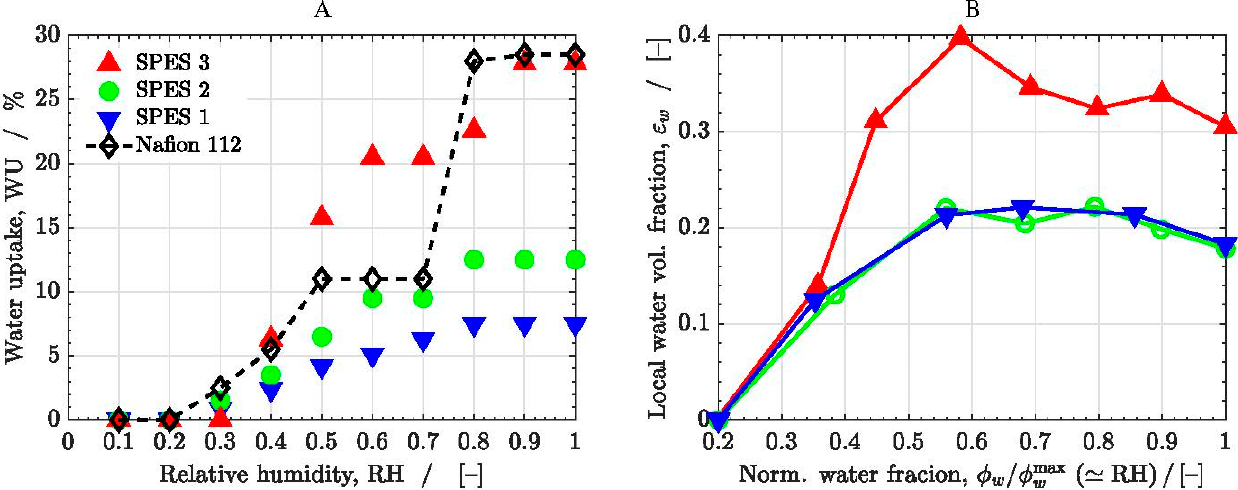
Figure 9. ( A ) Measured water uptake, WU%, as a function of relative humidity, RH, at T = 80 ◦ C of the SPES membranes. The results for Nafion 112 are also included. ( B ) Predicted local water volume fraction, ε w , as a function of the ratio φ w / φ max wr ( ≃ RH ).